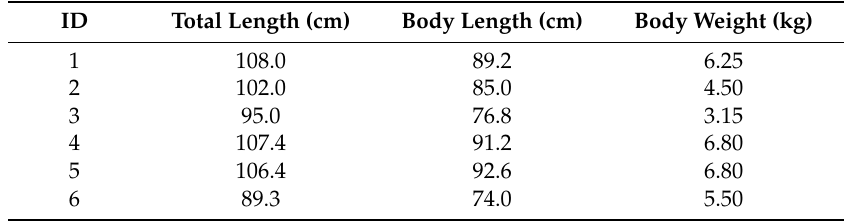
Table 2. Six Chinese sturgeons used for conducting the ex situ target strength measurements.